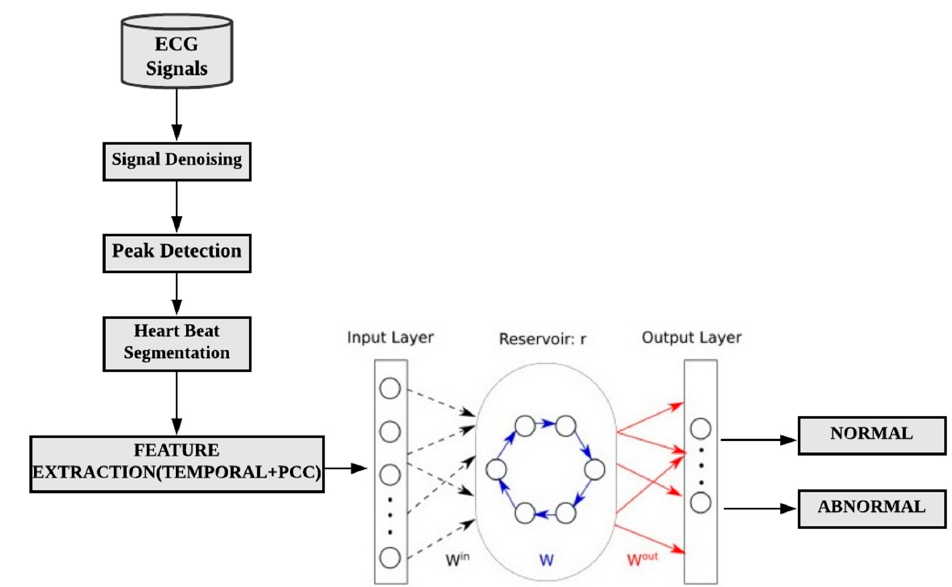
Figure 1. Schematic representation of ventricular heartbeat classifier.